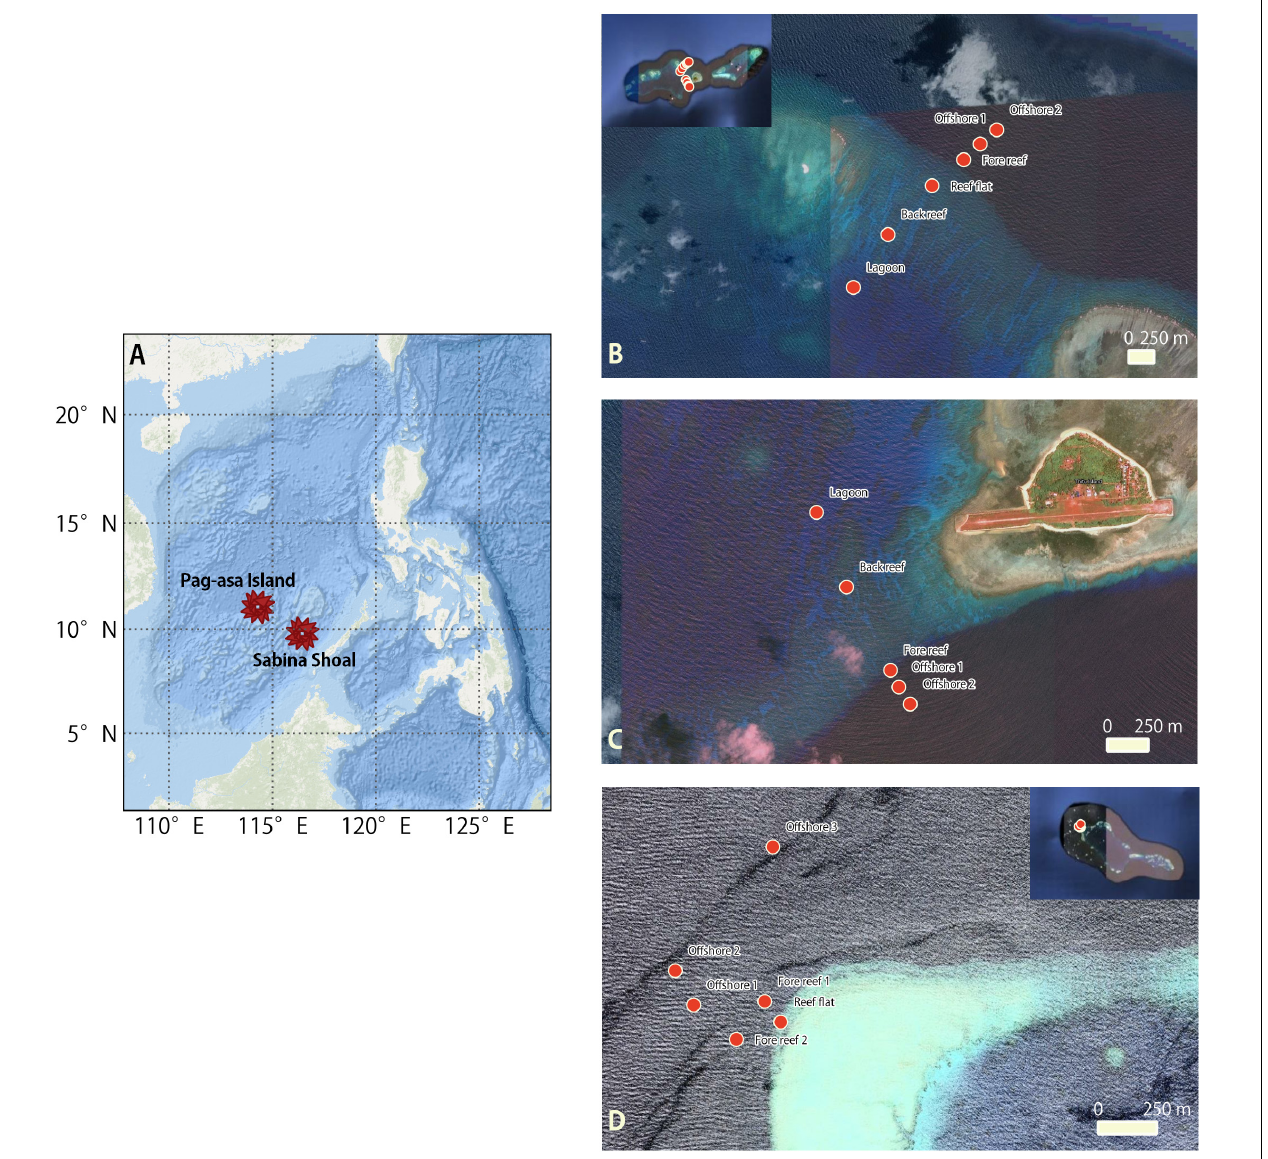
FIGURE 1 | Maps of the study sites in the Kalayaan Island Group. (A) Philippine map showing the West Philippine Sea and islands; (B) Pag-asa Island Transect 1 with the larger Pag-asa Island perspective showing the 2 transects as inset; (C) Pag-asa Island Transect 2; and, (D) Sabina Shoal Transect and the whole Sabina Shoal perspective as